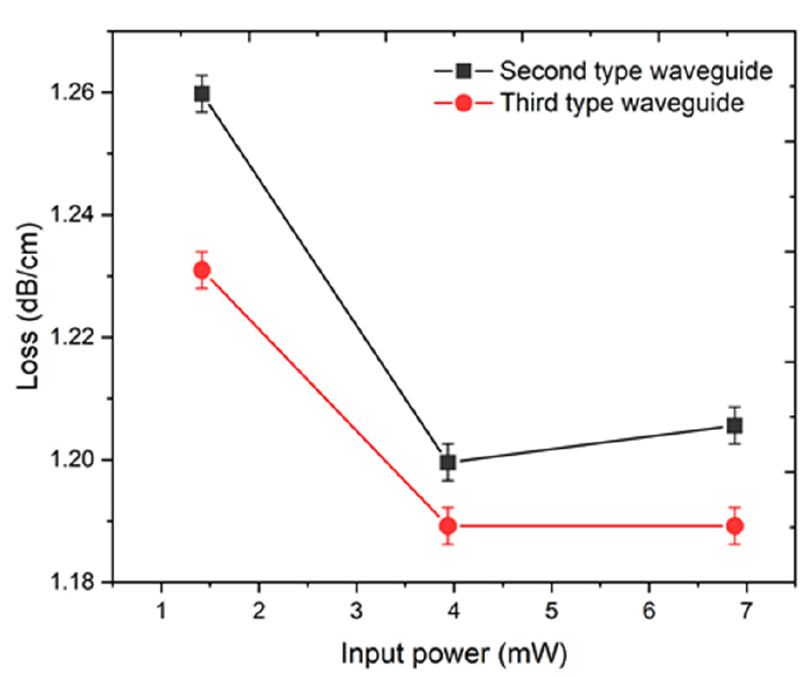
Figure 5. Insertion losses measurement of the second type waveguide (0.6 µJ pulse energy, ~10 4 pulses), and the third type waveguide (1.6 µJ pulse energy, ~600